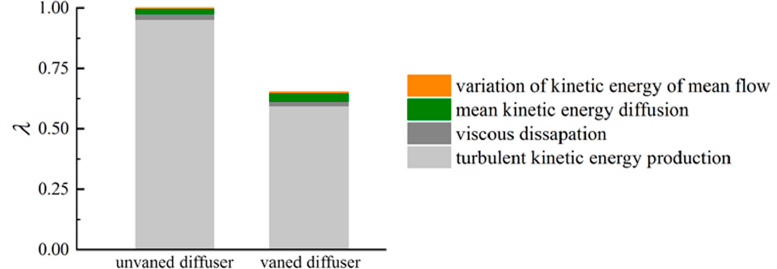
Figure 15. Composition of diffuser loss predicted in unvaned and vaned diffusers.